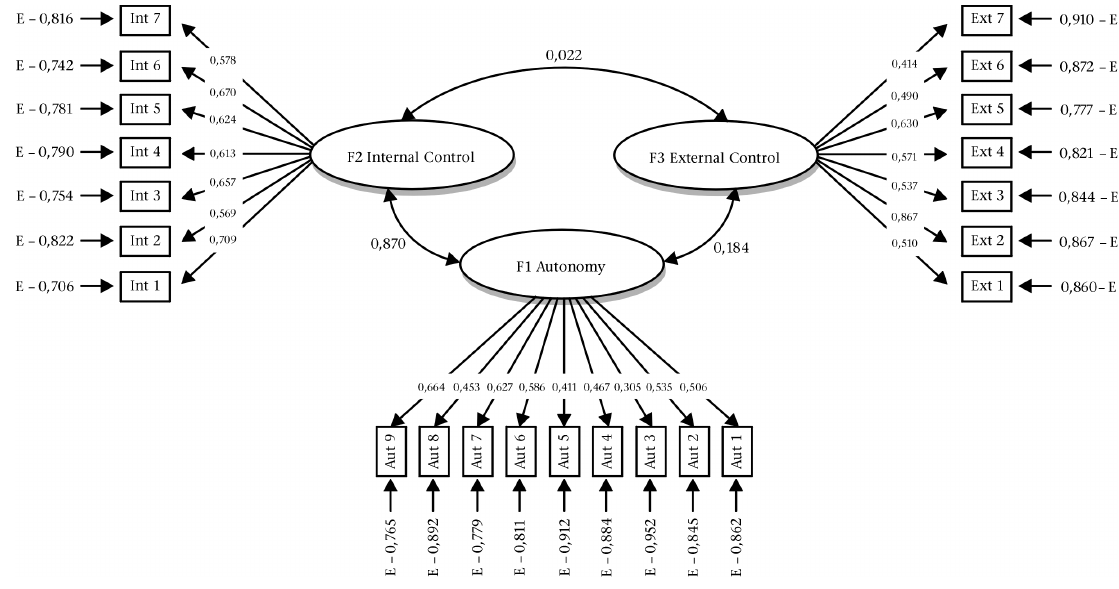
Figure 3: Standardised estimated parameters of the three-factor LCI model for the second language group